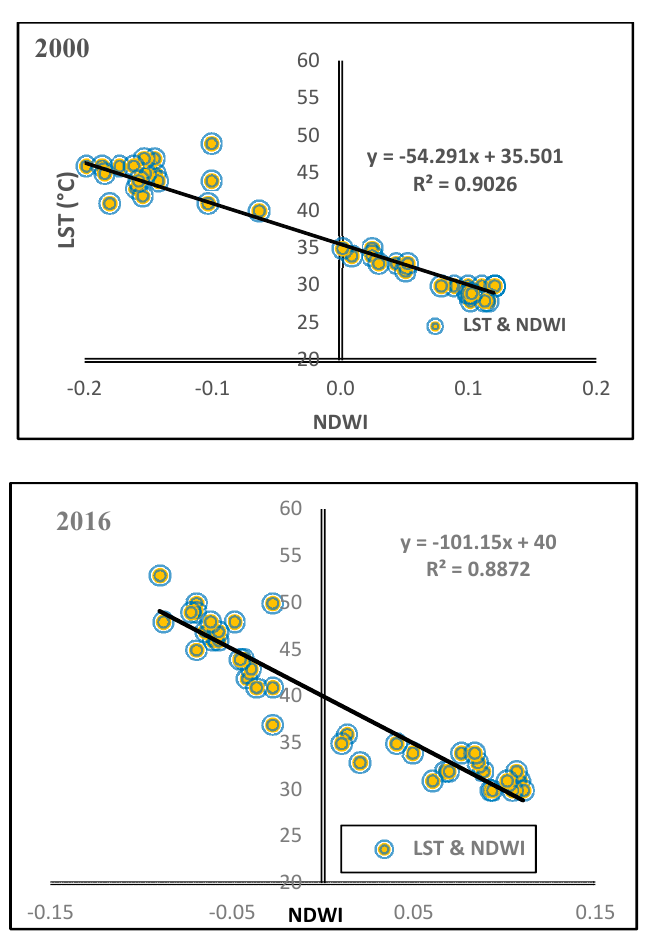
Figure 13. Correlation between NDWI and LST in the period of the study (1990, 2000 and 2016).